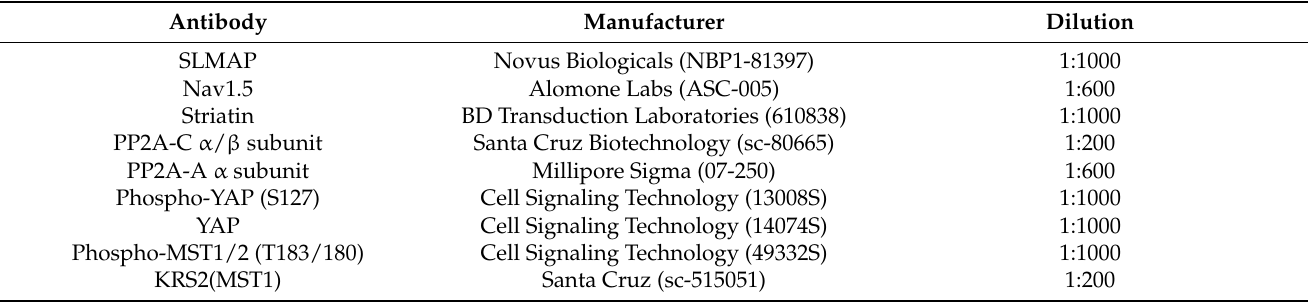
Table 1. List of antibodies used in this study. All antibodies used in this study are listed with the corresponding distributor, catalog number and dilution used for western blot.